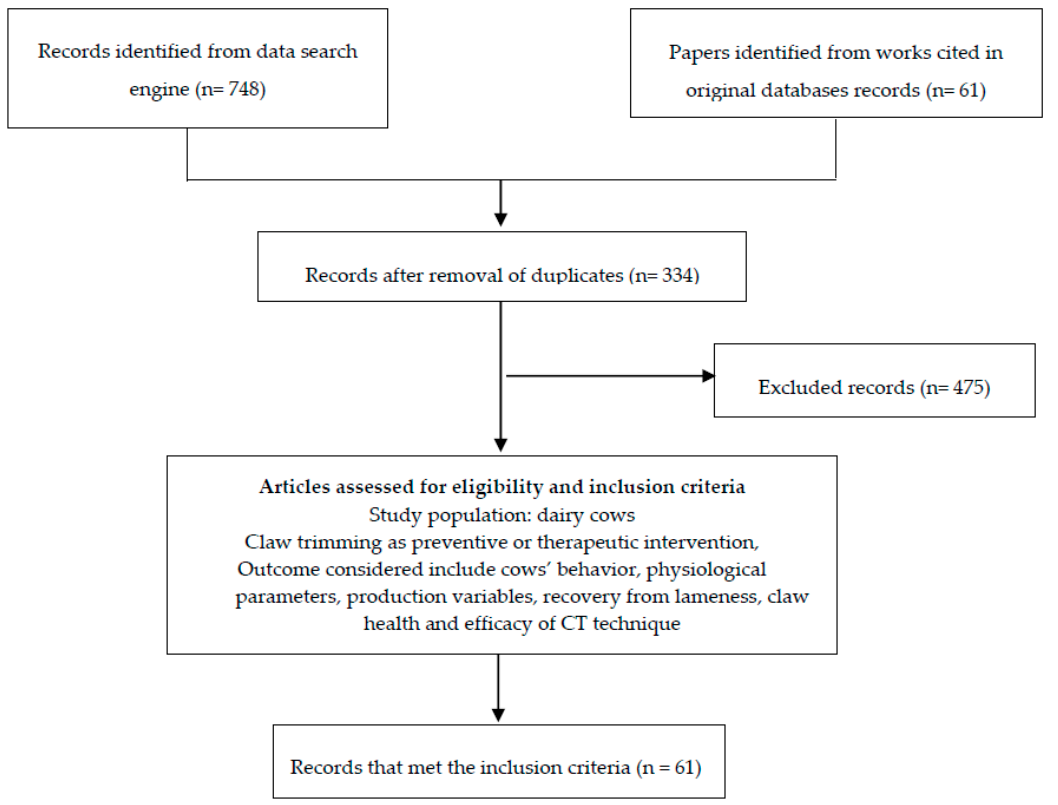
Figure 1. Flow diagram of study selection procedure.